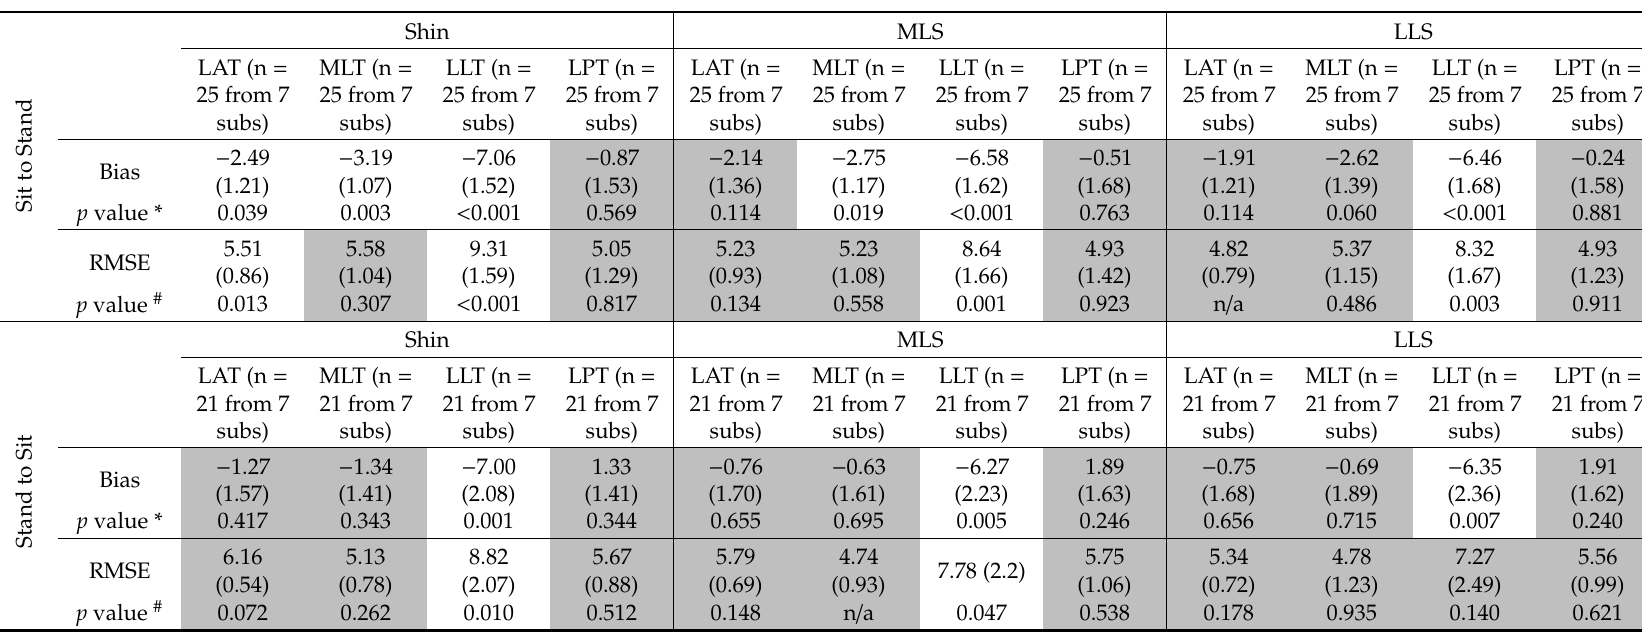
Table 5. Knee flexion bias and RMSE [least squares mean (standard error)] for each sensor combination versus gold standard MOCAP